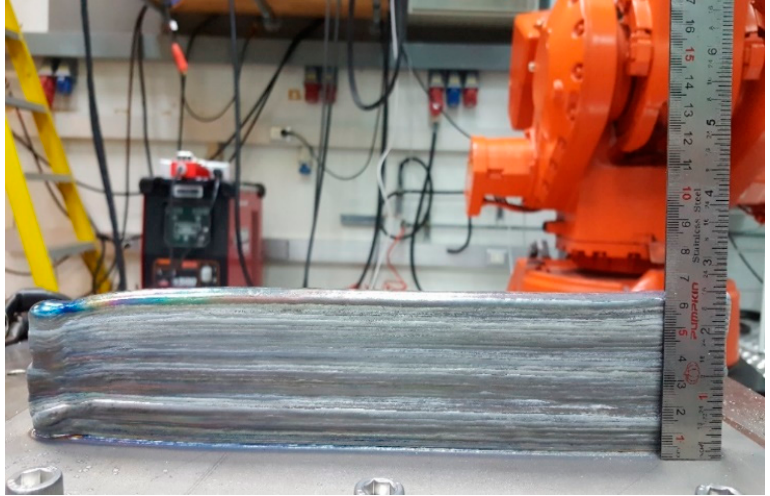
Figure 5. Photographs of the deposited walls: 36 layers.